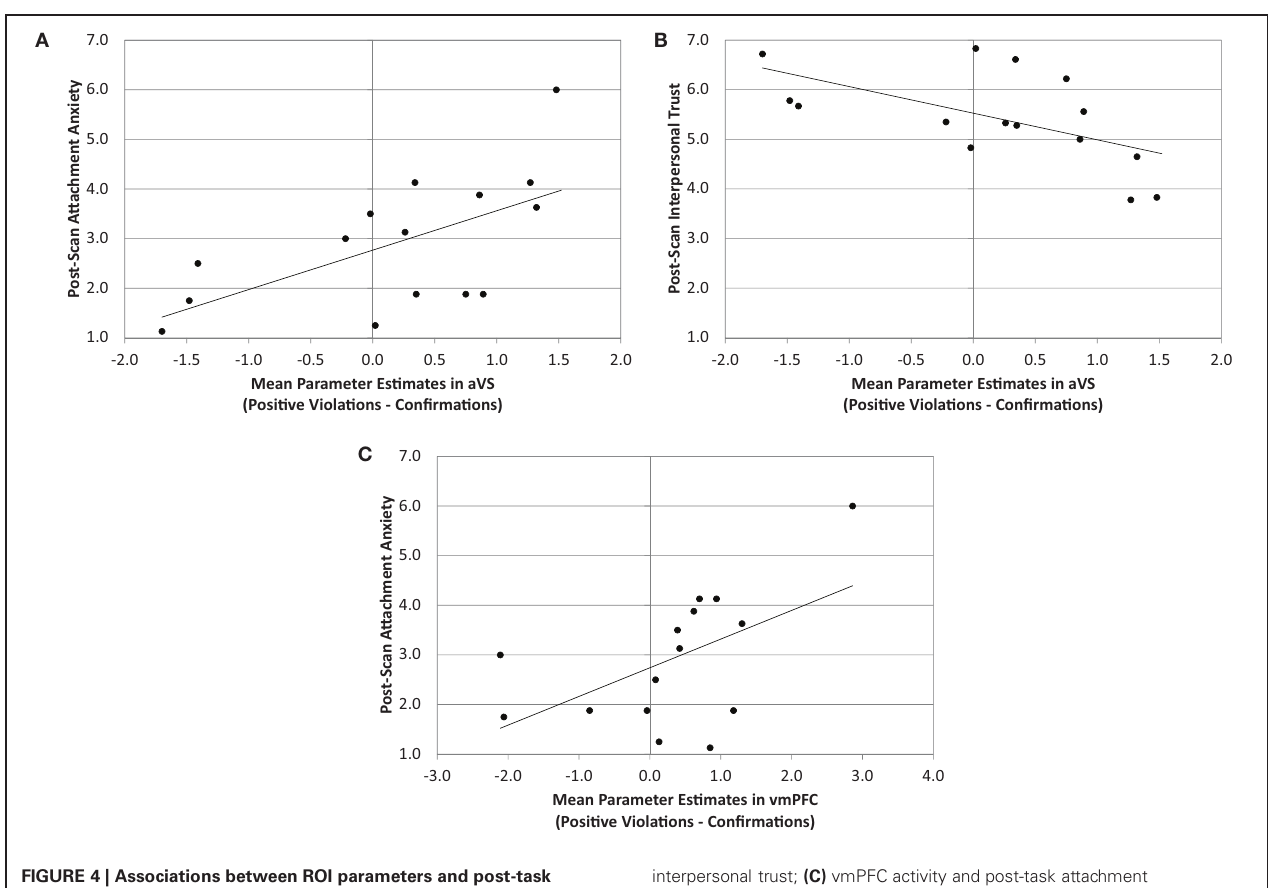
FIGURE 4 | Associations between ROI parameters and post-task measures. Significant associations between: (A) aVS activity and post-task attachment anxiety; (B) aVS activity and post-task